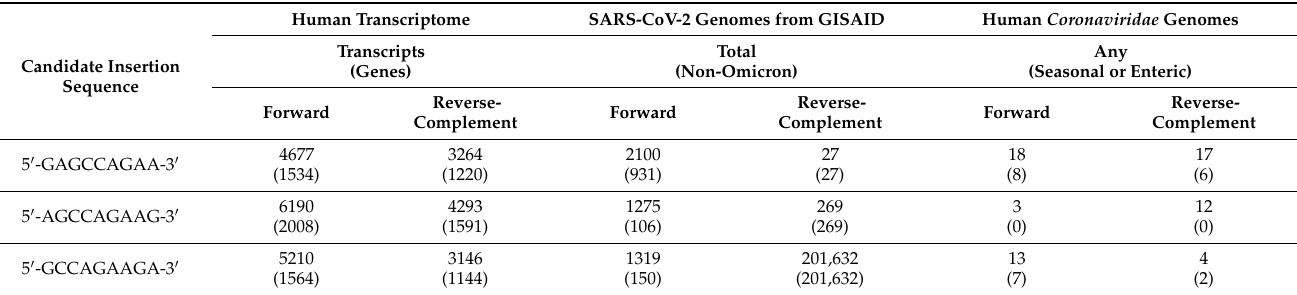
Table 1. Numbers of viral genomes and human transcripts with forward or reverse-complement matches to the three potential insertion sequences. Because the insertion sequences occur by definition in Omicron genomes, counts are shown separately for total SARS-CoV-2 genomes from GISAID and for genomes that are not assigned to the Omicron lineage. We confirmed that no sequences